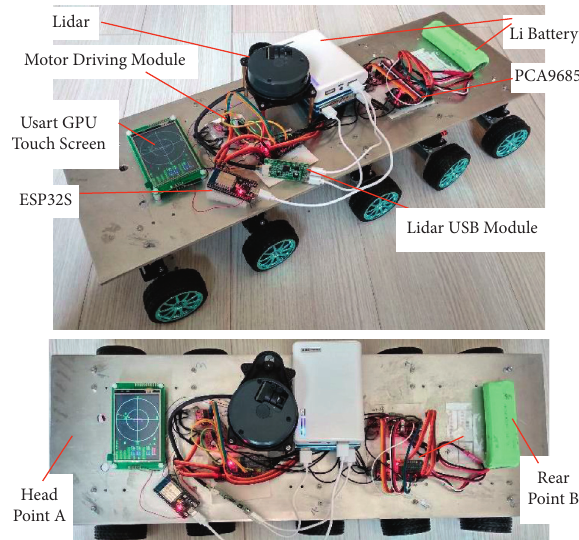
Figure 1: The architecture of a five-axle wheeled robot for research.